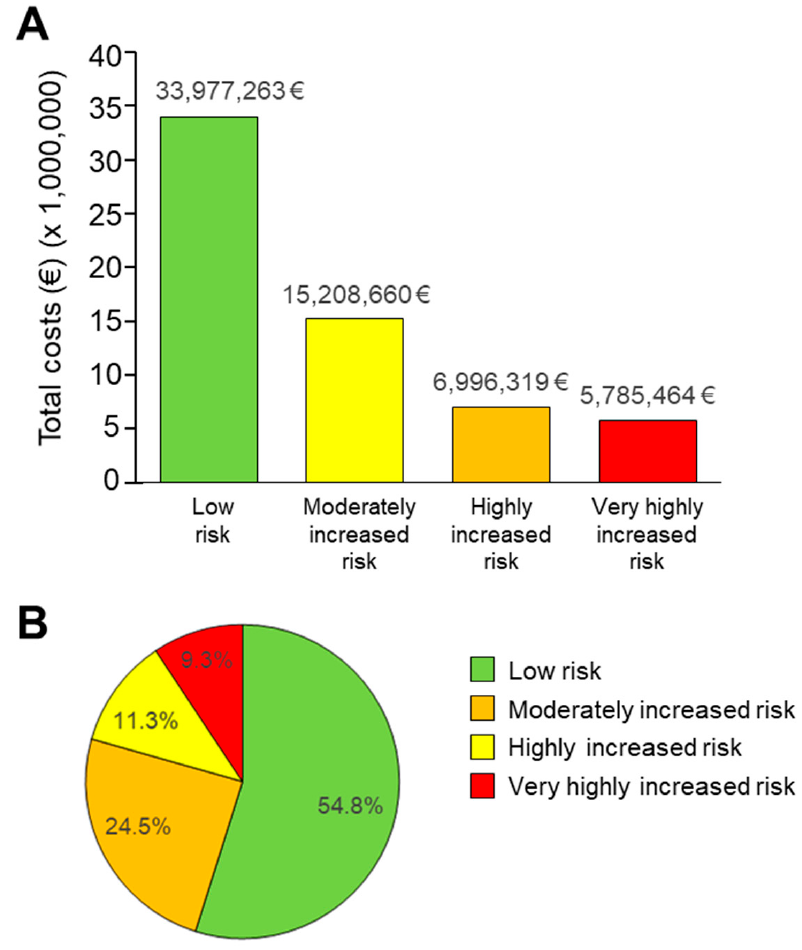
Figure 2. Total absolute costs associated to each KDIGO risk groups ( A ), and percent of costs of each KDIGO group ( B ).